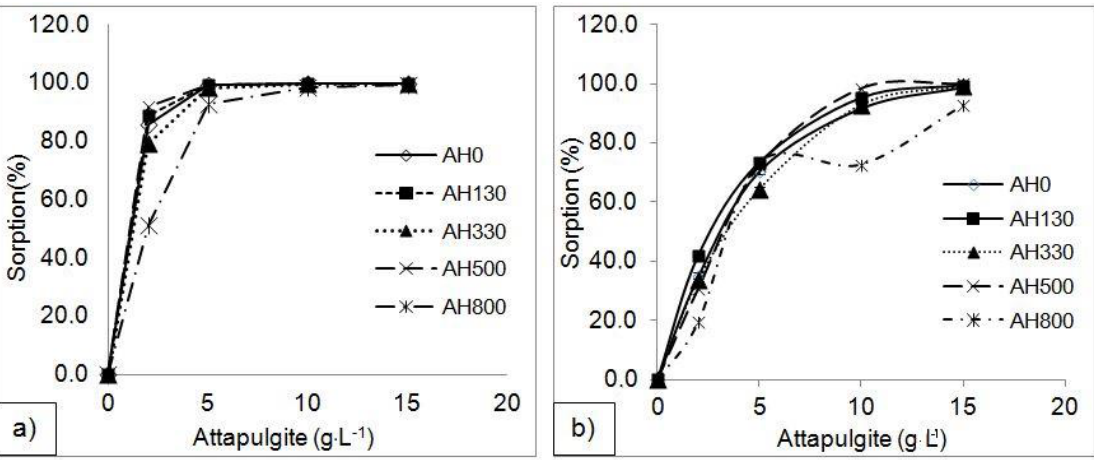
Figure 7. Sorption percentage of ( a ) Pb and ( b ) Cu for different solid content for raw and heat-treated ◦ C, 330 ◦ C, 800 ◦ attapulgite (130 °C, 330 °C, 800 °C) . attapulgite (130